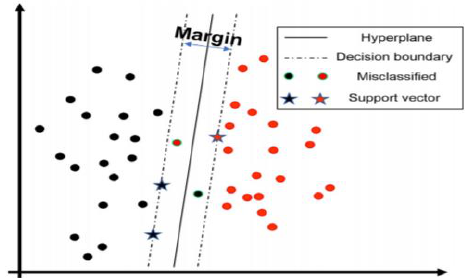
Figure 2. Implementation of Support Vector Machine (SVM) classifier [102]. Table 1. Comparison of The Related Studies.